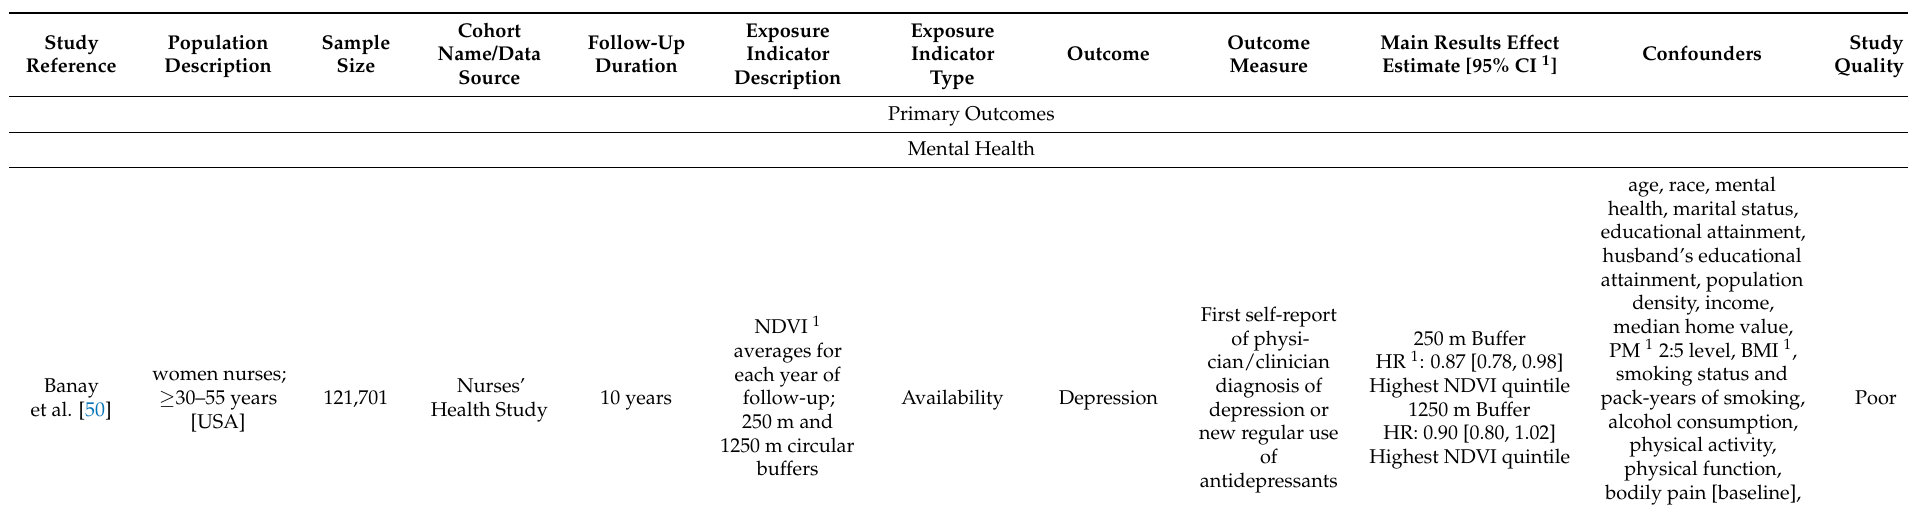
Table 1. Summary of study characteristics, results and quality